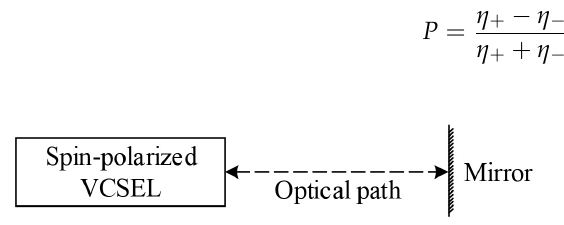
Figure 1. Schematic diagram of spin-VCSEL with optical